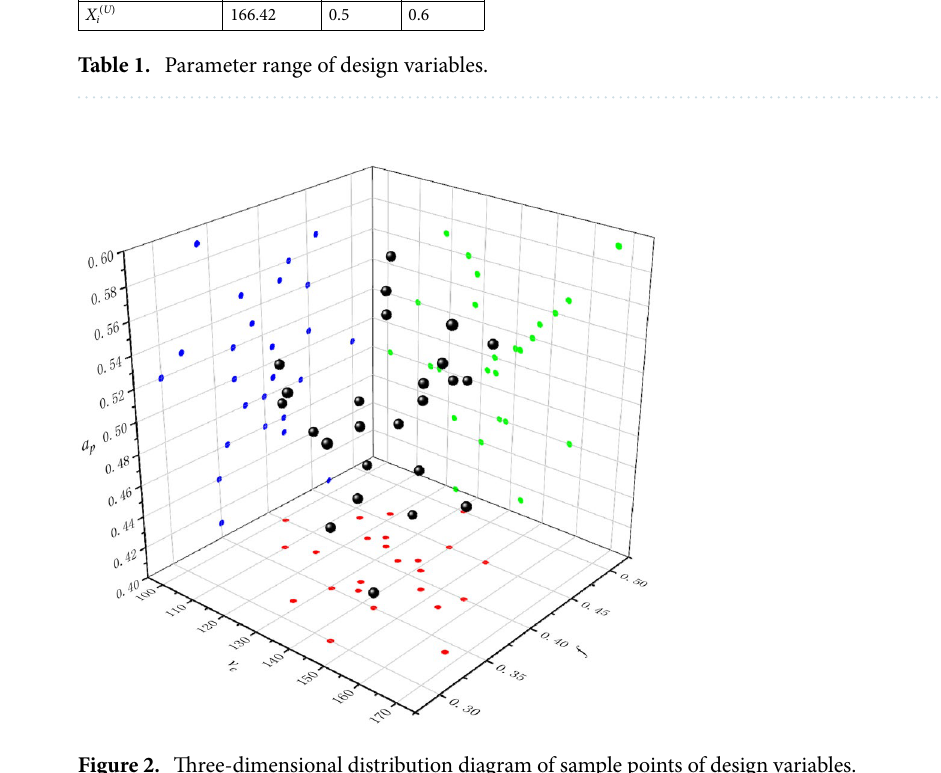
Figure 2. Three-dimensional distribution diagram of sample points of design